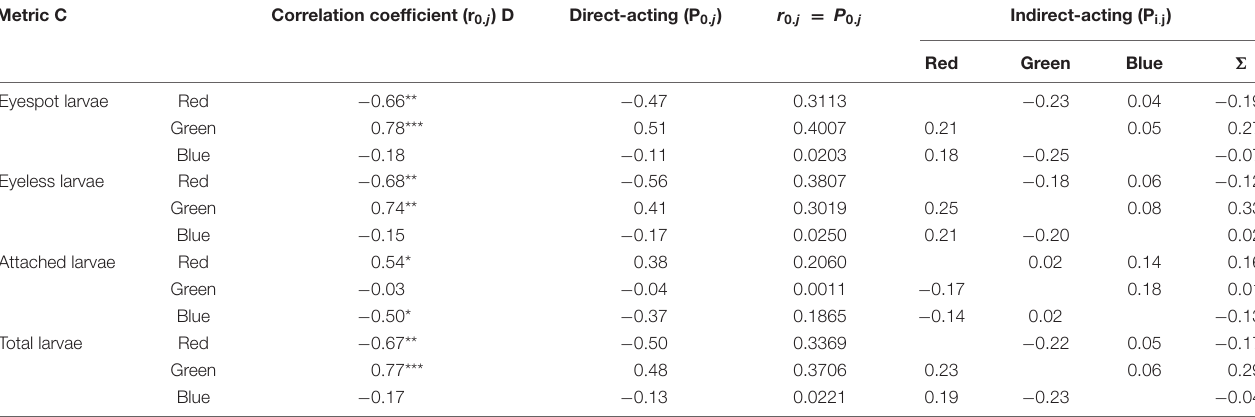
TABLE 10 | The path analysis for the distribution difference in eyespot larvae, eyeless larvae, and total larvae and the number of attached larvae of the hybrid oyster to the TPCs. Metric